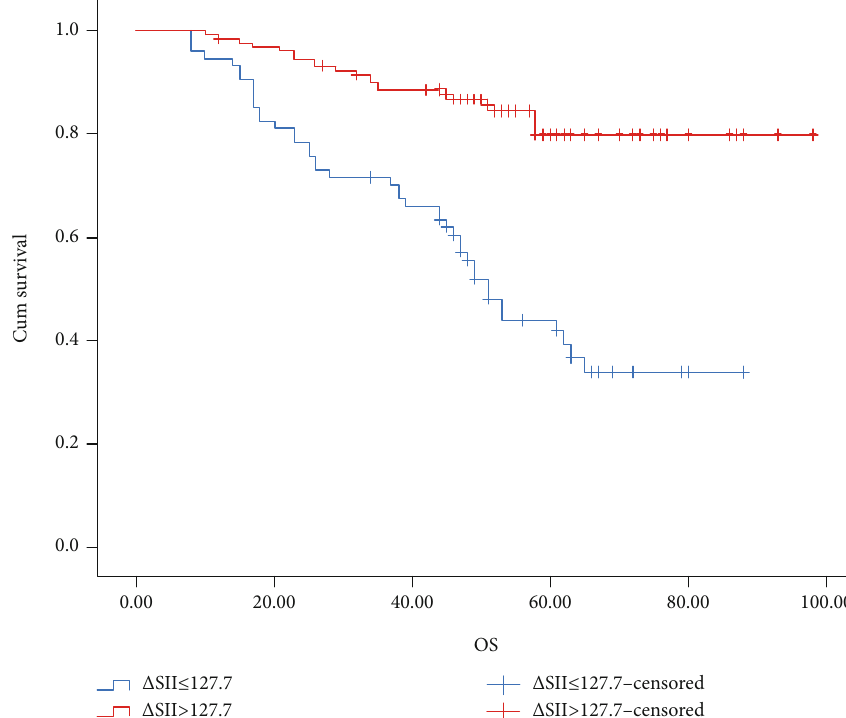
Figure 2: Kaplan-Meier graphs of overall survival for patients in the high- Δ SII group ( > 127.7) and low- Δ SII group ( ≤ 127.7).